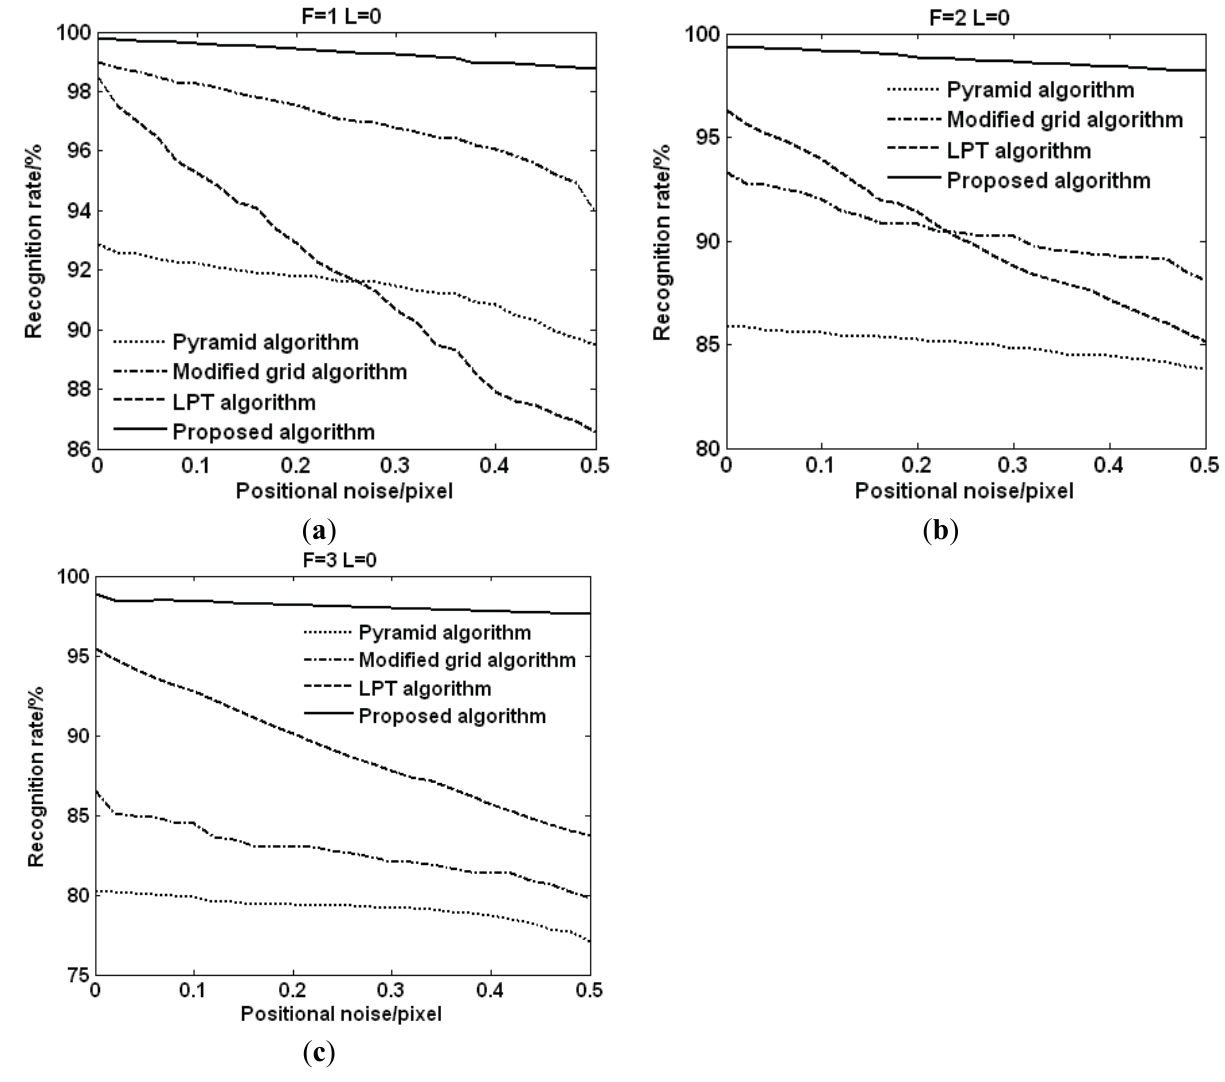
Figure 6. Recognition rate vs . false stars. ( a ) Recognition rate with 1 false star; ( b ) Recognition rate with 2 false stars; ( c ) Recognition rate with 3 false